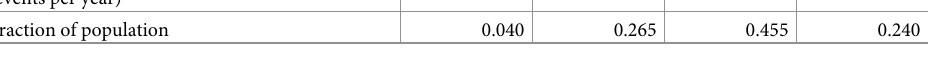
Table 2. Frequency of events of consuming barbequed meat per year for fractions of the Danish population. Frequency of consuming barbecued meat (events per year)